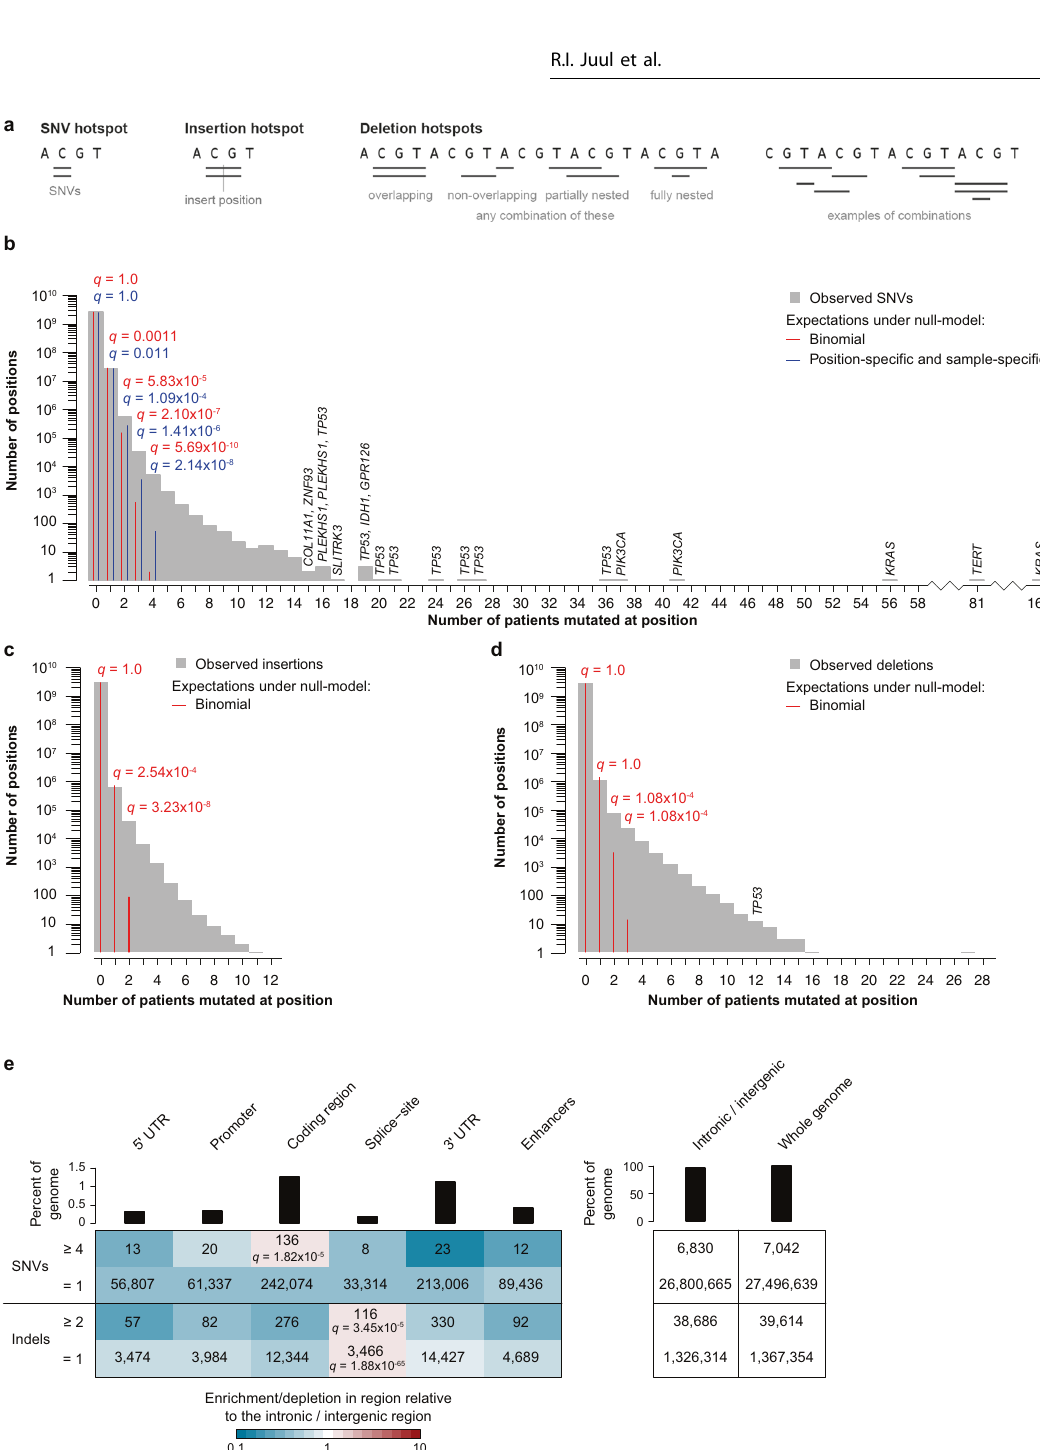
Fig. 1 Overview of detected site-speci fi c hotspots. a . Schematic de fi nition of SNV-, insertion-, and deletion hotspots. b – d Bar-charts showing the number of hotspots with a speci fi c number of mutations for SNVs (b), insertions (c), and deletions (d) with expectations under null hypotheses; exact q -values are reported when null models predict at least one hotspot; remaining q -values are reported in Supplementary Table 1. e . Heatmap of hotspot enrichment/depletion across various genomic regions; bars show the genomic extent of each region; for the protein-coding and gene regulatory regions q = 1 when not stated among protein-coding regions (3.25x; q = 6.15 × 10 − 19 ), and non- signi fi cant enrichments among promoters (1.75x; q = 0.287), 5 ’ UTRs (1.51x; q = 0.667), and splice-sites (1.27x; q = 1; Supple-